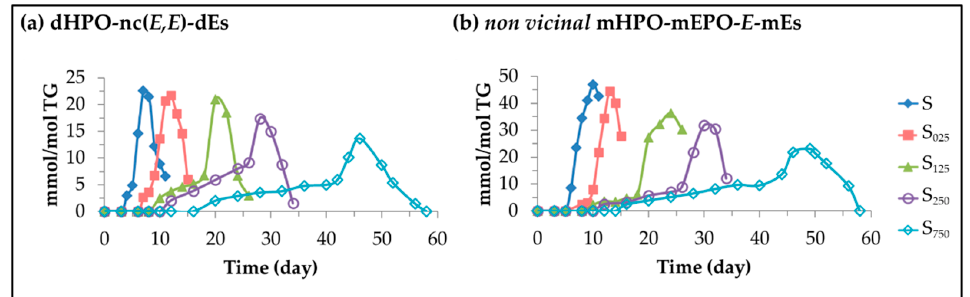
Figure 7. Evolution of the concentration, expressed in mmol/mol TG, in samples S, S 025 , S 125 , S 250 and S 750 over the storage time at 70 °C up to a very advanced oxidation stage, of: ( a ) dHPO-nc( E,E )-dEs; and ( b ) non vicinal mHPO-mEPO- E